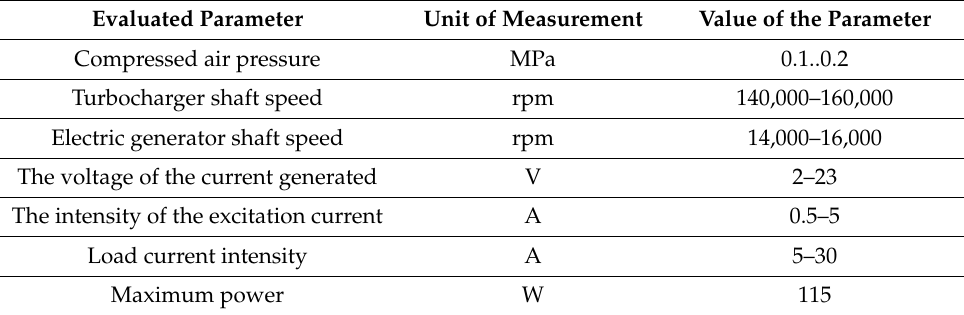
Table 2. The resulting parameters.